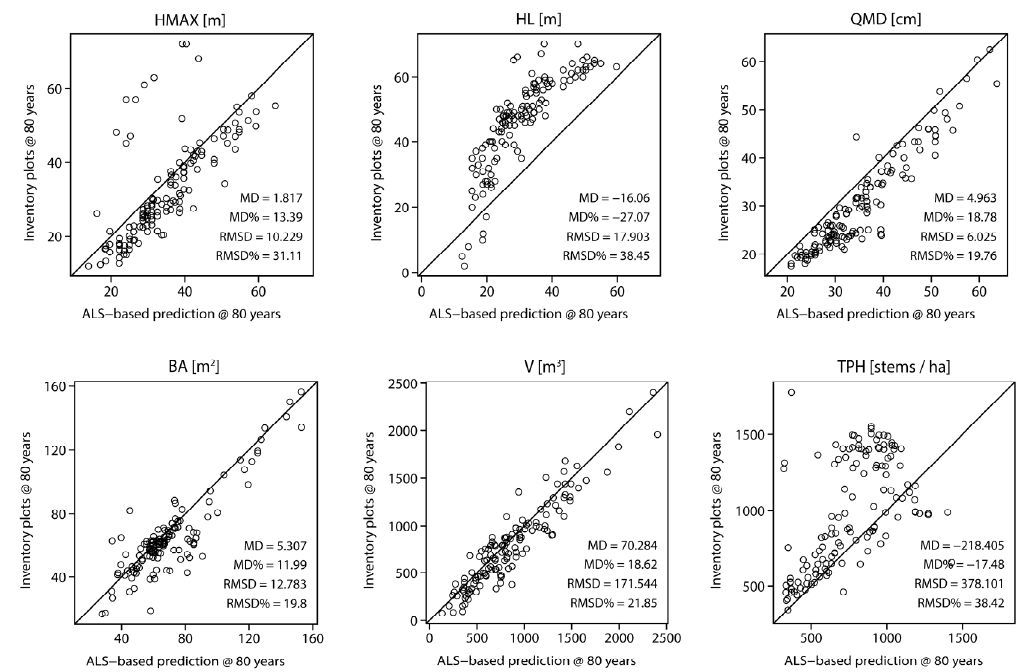
Figure 8. Comparison of six chosen forest stand attributes projected to 80 years at plot-level. Observed values are derived by projecting field measurements, whereas predicted values are derived with the proposed method.